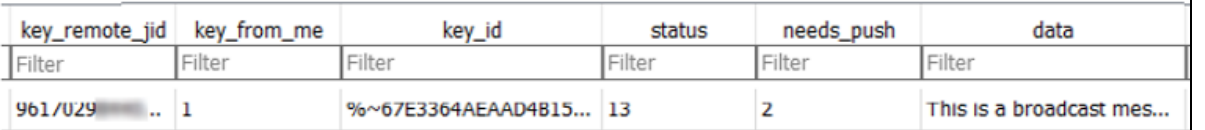
Figure 22. Broadcast message - recipient